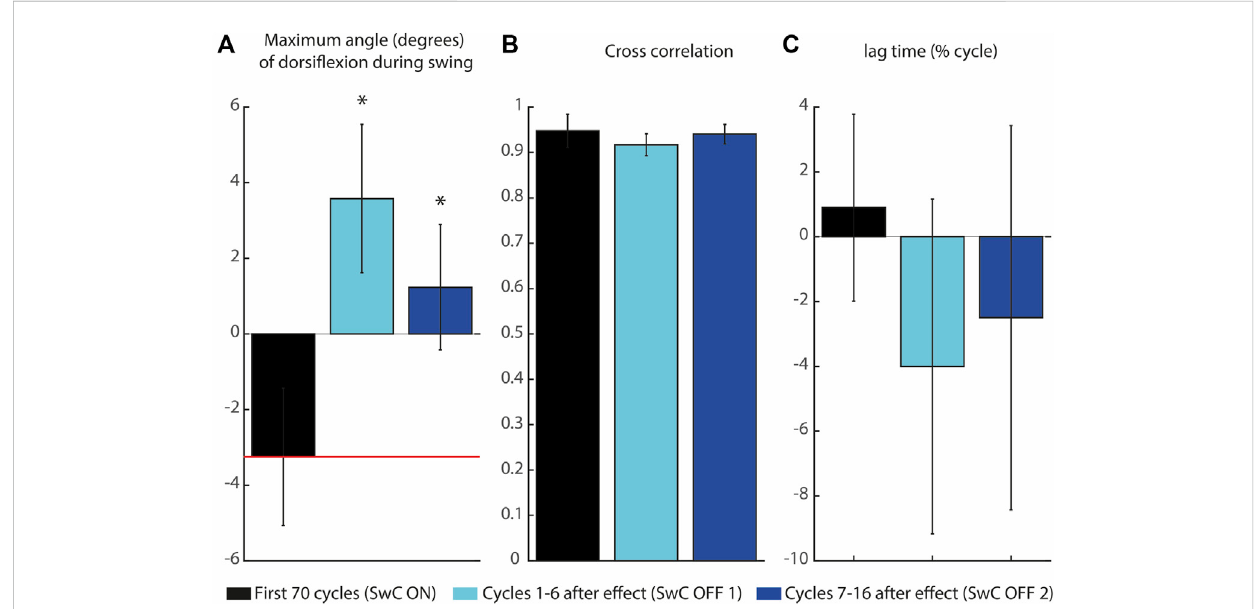
FIGURE 10 Maximum angle of dorsi fl exion during swing and cross-correlation of the three SwC conditions. (A) Maximum angle of dorsi fl exion during swing. The horizontal red linerepresents thetarget peakofdorsi fl exion during swing. (B) Cross-correlation coef fi cients between ankle angle trajectories for the three SwC conditions (SwC ON,SwC OFF1 and SwC OFF 2)and the target trajectory. (C) Lag time ofmaximumcross-correlation betweenthe three SwC conditions and target trajectory. Negative lag time means that the trajectory was performed earlier in the cycle relative to the target trajectory. p < 0.05*.